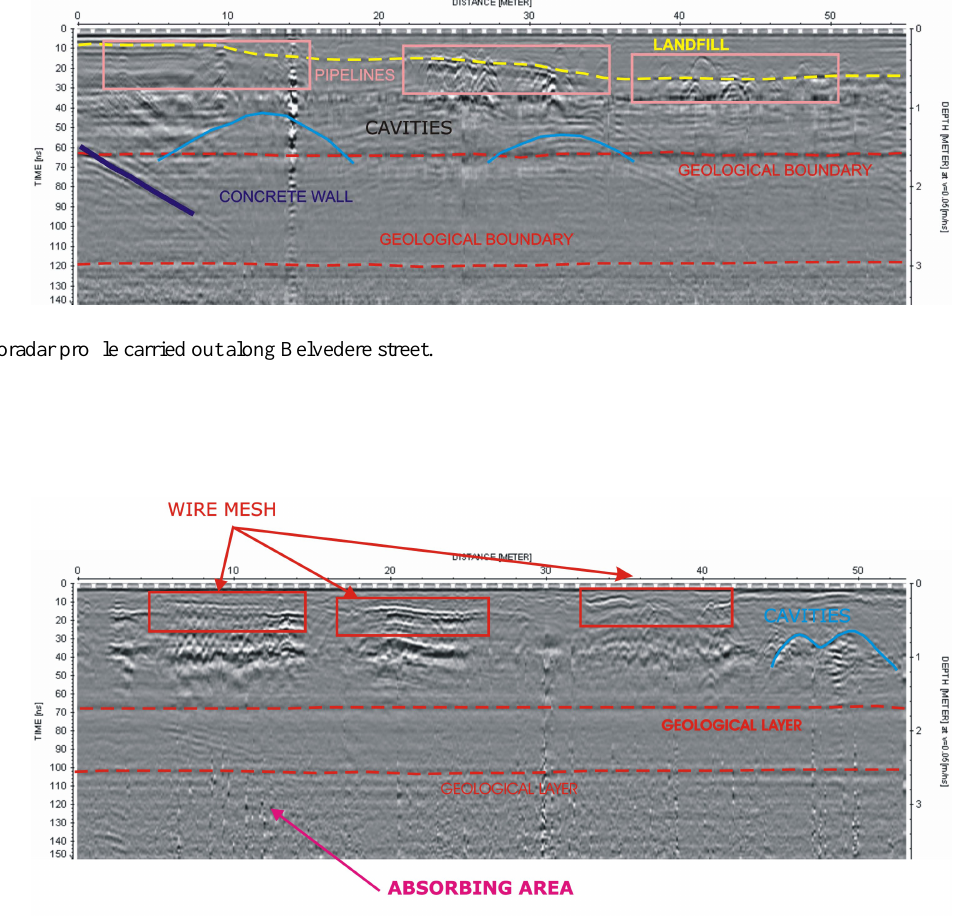
Fig. 5. PS1 georadar profile carried out along Pisacane street. They are also shown the geological layers that site surveys indicate as a succession of pumices and ashes.